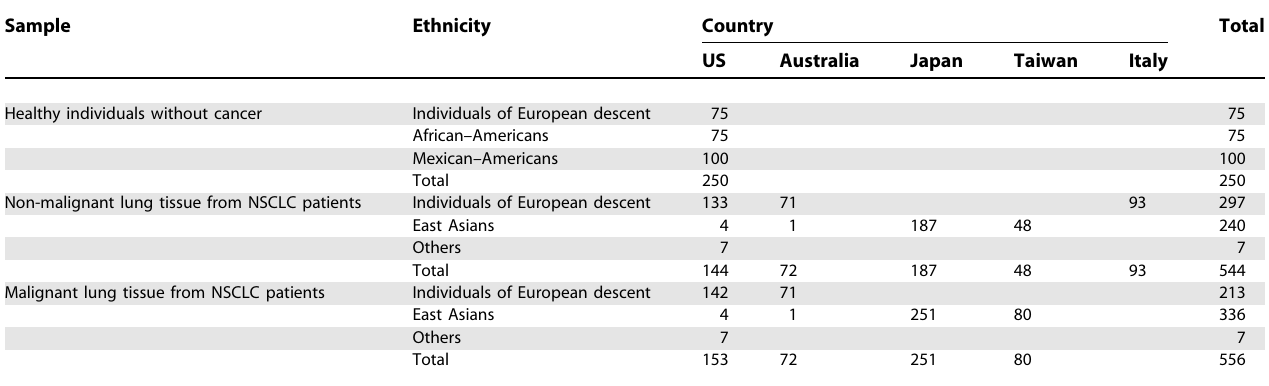
Table 2. Summary of Germline (Blood) and Malignant and Non-Malignant Lung Tissues Examined Sample